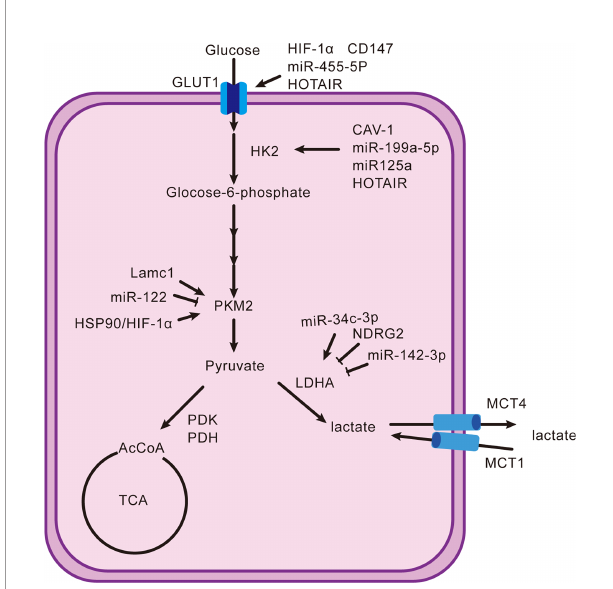
FIGURE 1 | Production and reduction mechanism of lactate. It shows the classical intracellular pathway(s) that generates lactate and their upregulators or downregulators from the proteomic, genomic, and transcriptomic